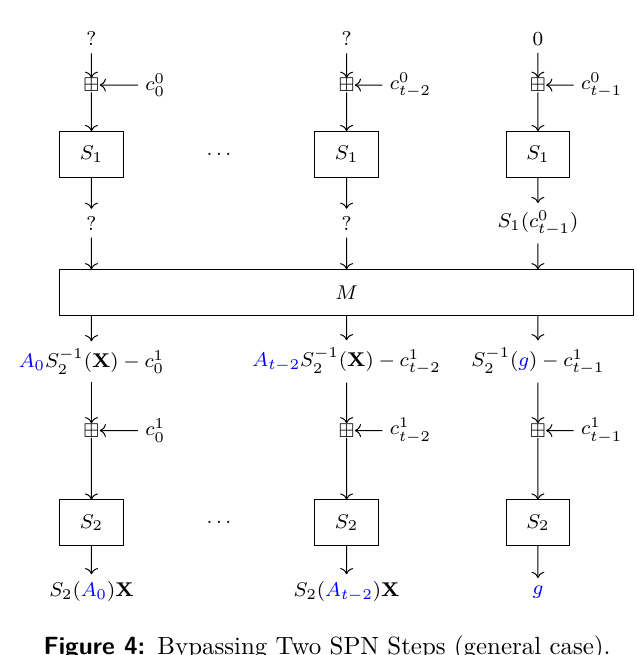
Figure 4: Bypassing Two SPN Steps (general case).